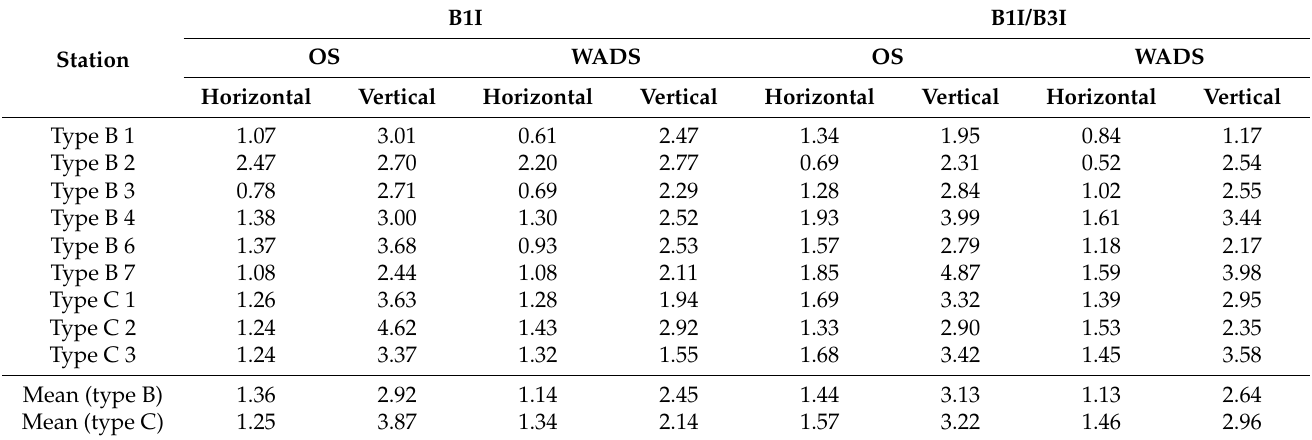
Table 6. The B1I and B1I/B3I positioning accuracy in the OS and the WADS after correcting